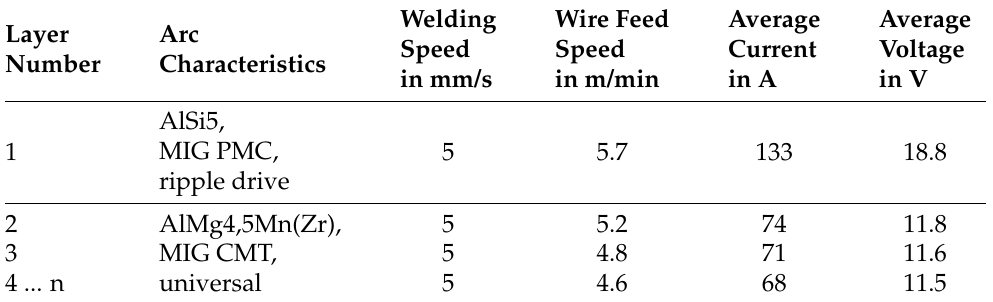
Table 2. The welding parameters used for WAAM, including the initial bonding layers and the actual building process.